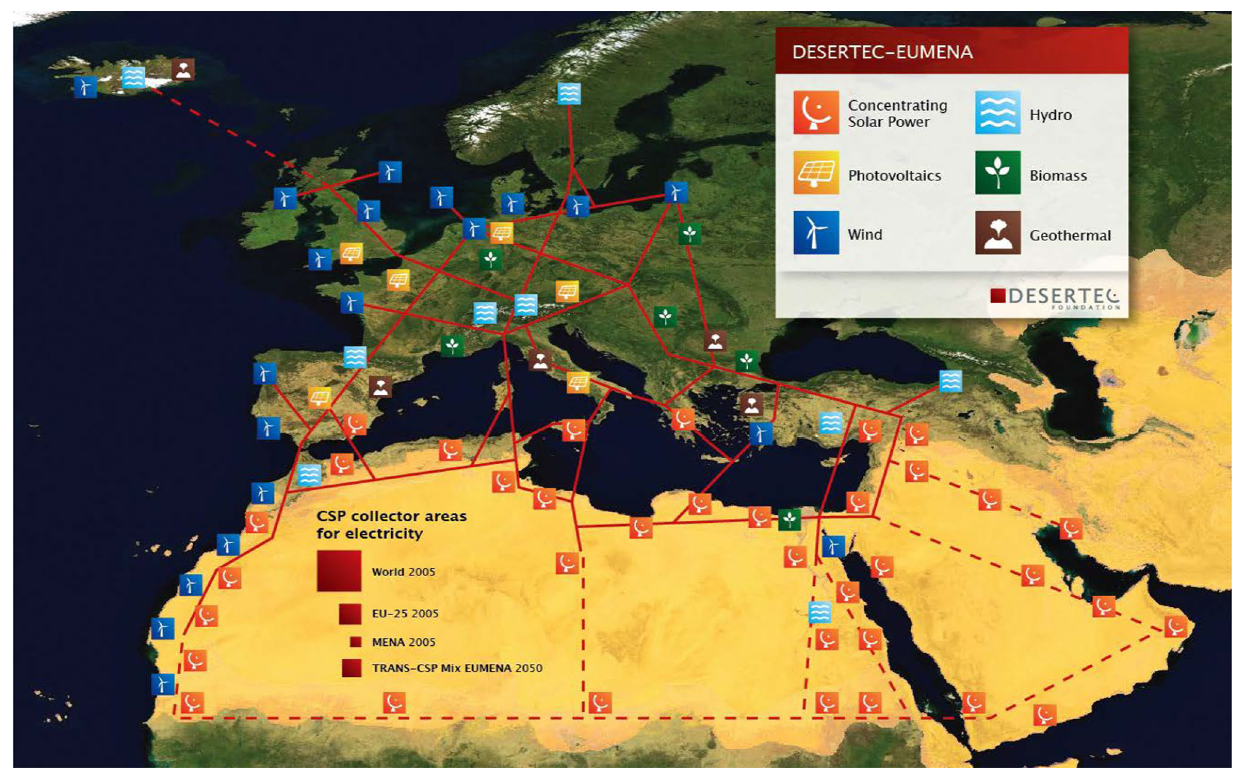
Fig. 8 Hydroprojects in MENA